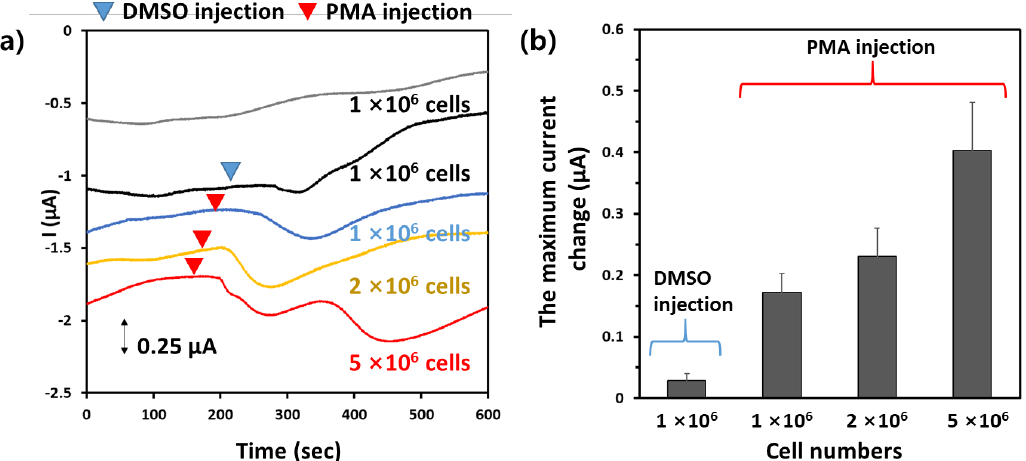
Figure 5. ( a ) Amperometric responses of the PtNP/rGO–CNT/PtNP/SPCE electrode for H 2 O 2 released from LNCaP cells (1 × 10 6 cells) without any treatment (gray line) and after addition of DMSO (black line), as well as different cell numbers such as 1 × 10 6 cells (blue line), 2 × 10 6 cells (yellow line), and 5 × 10 6 cells (red line) after the addition of PMA at −0.2 V. ( b ) The maximum current change by H 2 O 2 release in LNCaP cells according to the cell number.